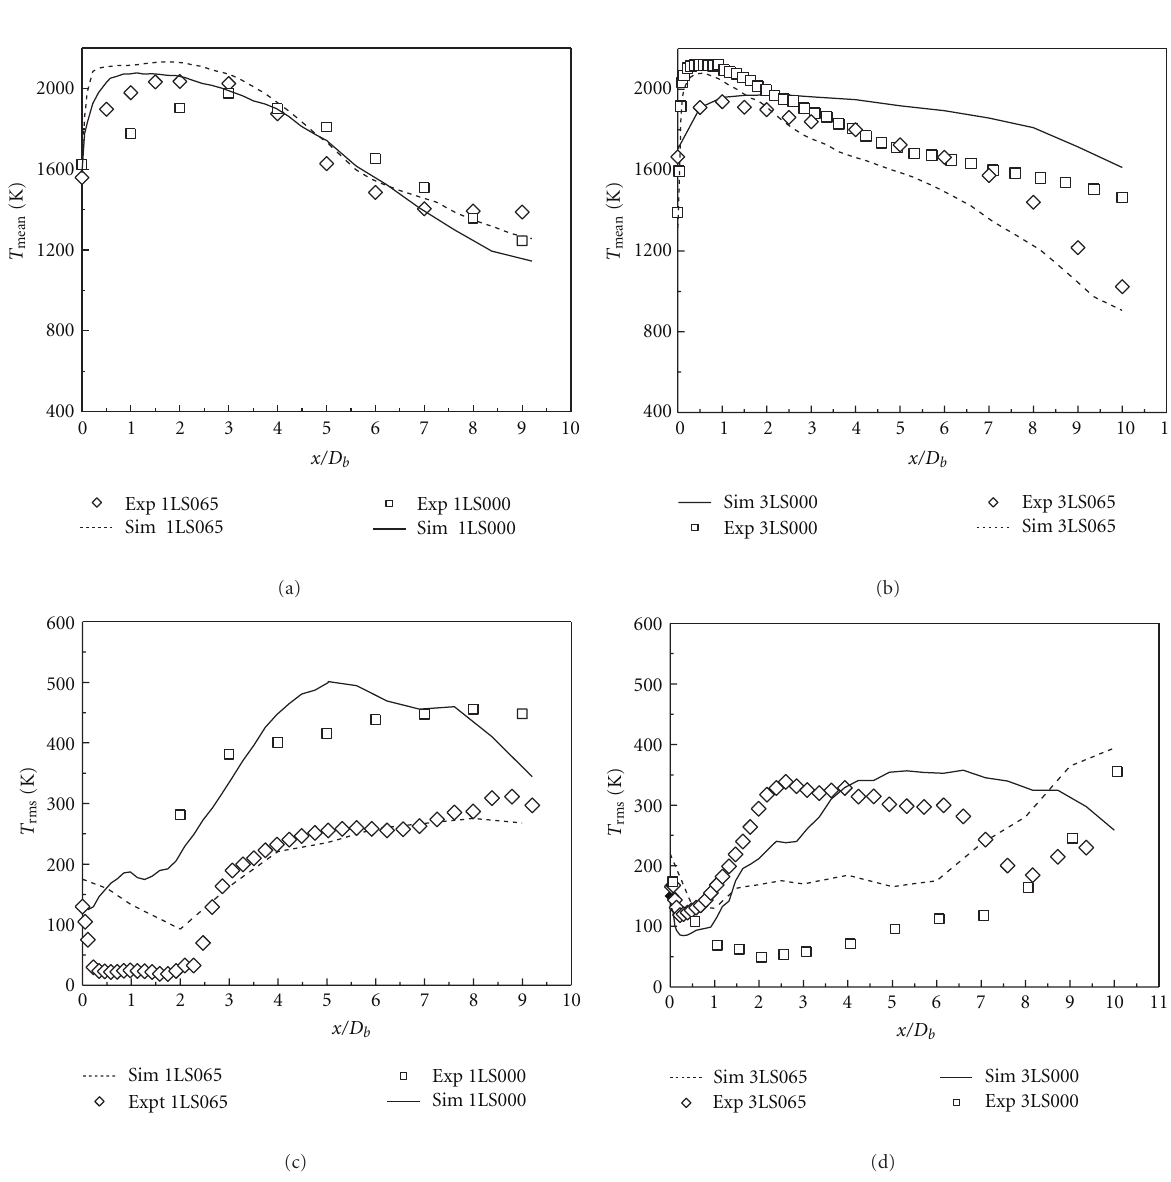
Figure 8: Center-line comparisons of the time mean (a, b) and rms (c, d) temperatures along the wake axis for the single- and the three-disk set ups and for swirl intensities of 0 and